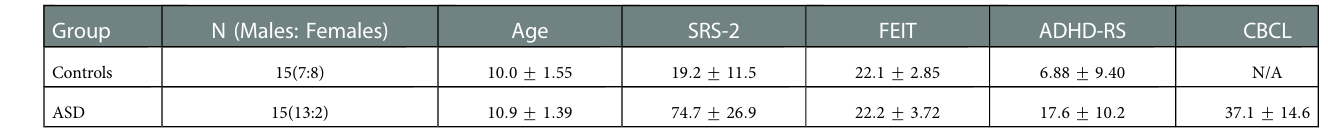
TABLE 2 Details of children